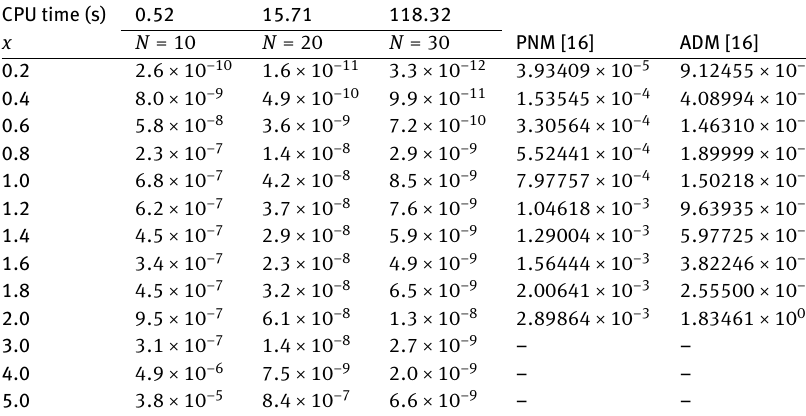
Table 4: Comparison of absolute errors for ( a = 1, b = 2, c = 1/2, e = 1, α 1 = 0.00196, α 2 = 0.07621) and h = 1 for Example 3.